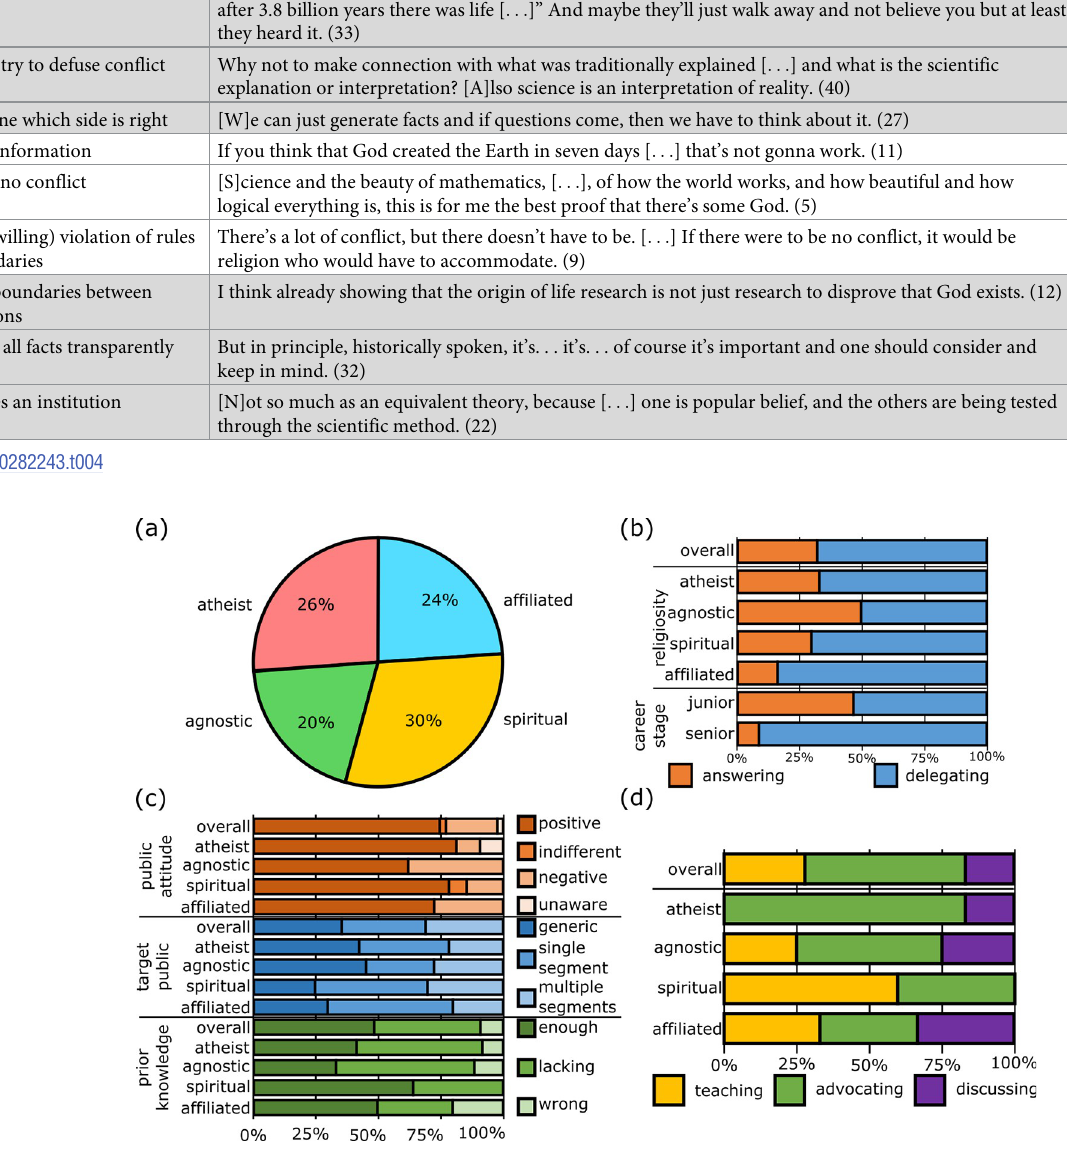
Fig 4. Religion and science in origins of life. (a) Religious composition of the sample, roughly equally divided between atheists, agnostics, spiritually inclined and religiously affiliated to some degree (N = 46). (b) Prevalence of answering (orange) and delegating (blue) profiles in the science-religion controversy (n = 28). (c) How different religious segments see: the public attitude towards OoL (brown series), the target public (blue series), and the public’s prior knowledge of OoL (green series) (N = 46). (d) Prevalence of the teaching (yellow), advocating (green), and discussing (purple) profile by religiosity (n = 18).